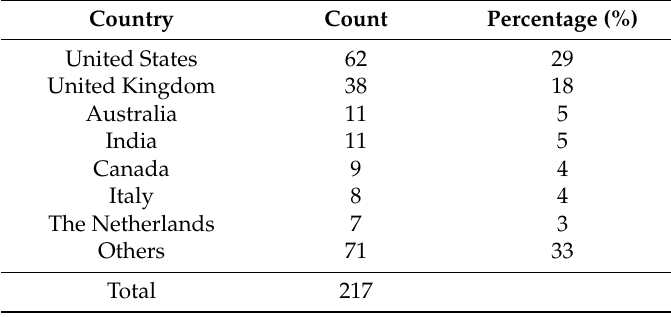
Table 1. Distribution of papers authored by independent researchers based the author’s country.